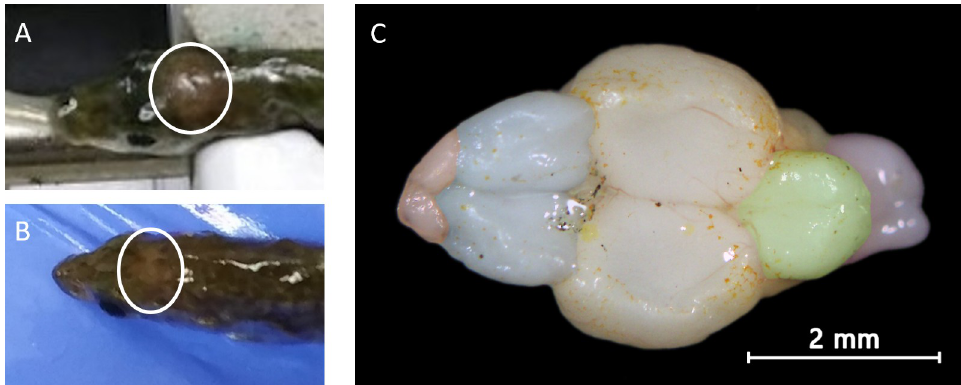
Fig 2. Dorsal visualization of the stickleback brain. A & B) Example visualizations of the stickleback brain through the skull. Circled is a lighter area corresponding to the diencephalon. C) The brain of a stickleback with olfactory bulbs (anterior, far left, colored red), telencephalon (left, colored blue), diencephalon and mesencephalon (center, natural color), cerebellum (right, colored green), and brain stem (posterior, far right, colored purple). Nodes of the social decision-making network are present in the telencephalon (amygdala, hippocampus, etc) and diencephalon (preoptic area (POA), hypothalamus, and periaqueductal gray/central gray (PAG)) as described in O’Connell and Hofmann [50].